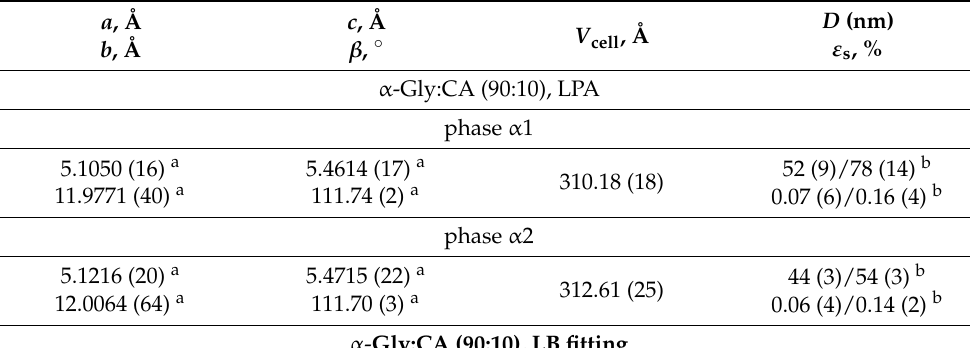
Table 6. Results of LPA (WHP and SSP) and LB and Rietveld fitting of the α -Gly:CA (90:10) and γ -Gly:CA (80:20) XRD powder patterns measured at 313 ± 1